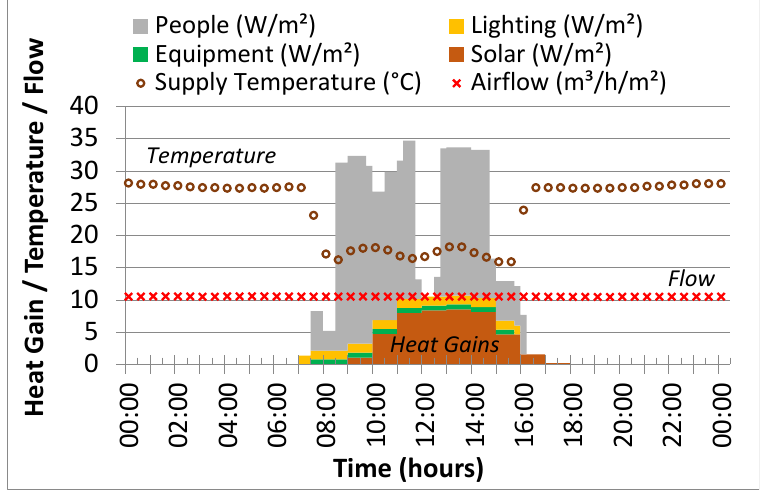
Figure 9. Specific internal heat gains, specific airflows, and supply air temperatures for the field test. ature, radiant temperature, CO 2 concentration, and airflow and airspeed. The temperatures supply air diffusers and return air grilles. Two instrumented vertical poles, placed in the south and east corners of the classroom, were used for measuring air temperature and CO 2 stratification in the room. Each pole had a set of temperature and CO 2 sensors installed at four different heights of 0.1, 1.1, 1.7, and 2.7 m. All air temperature sensors had an operating range of − 20 to 70 ◦ C, an accuracy of ± 0.21 ◦ C, and a resolution of 0.024 ◦ C. The CO 2 sensors had an accuracy of ± 50 ppm over the measured concentration